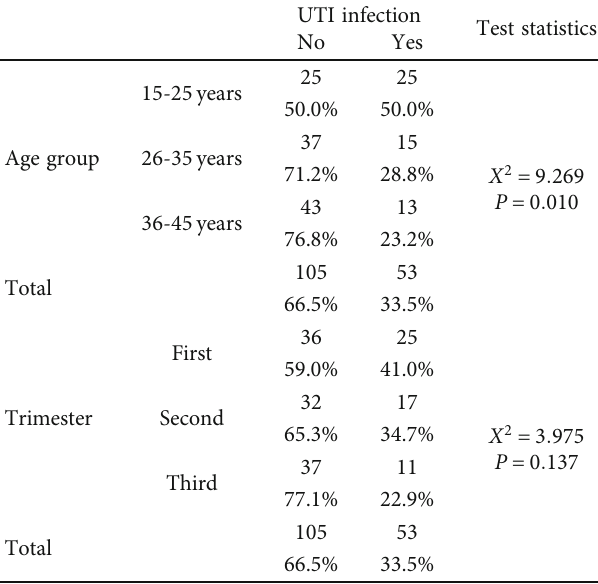
Table 2: Results of urinalysis and prevalence of UTI among the pregnant women.